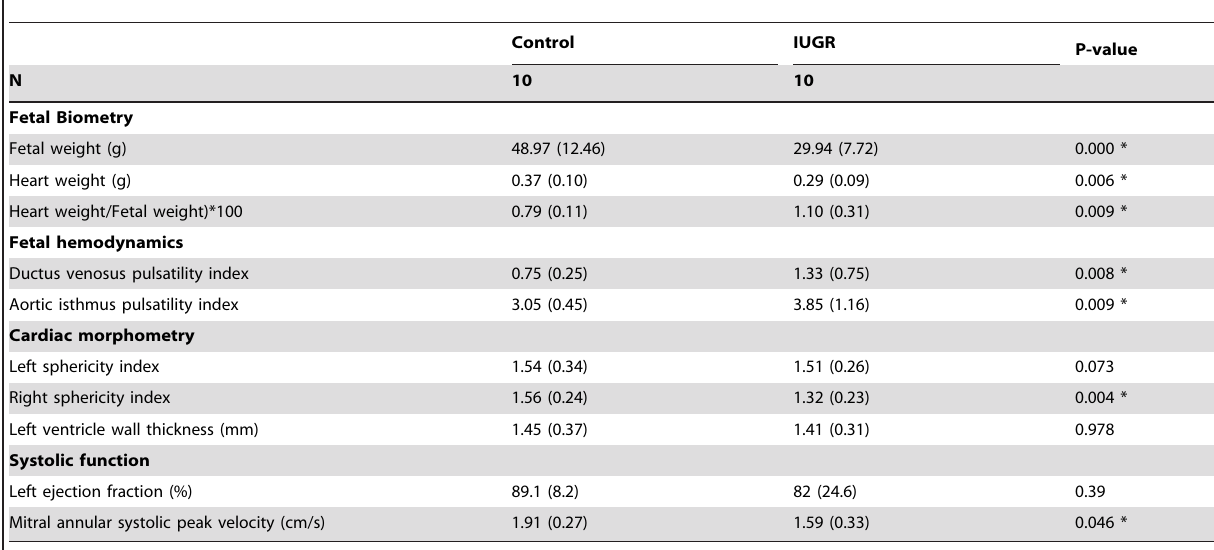
Table 1. Fetal biometric and echocardiographic results in IUGR and control fetuses.